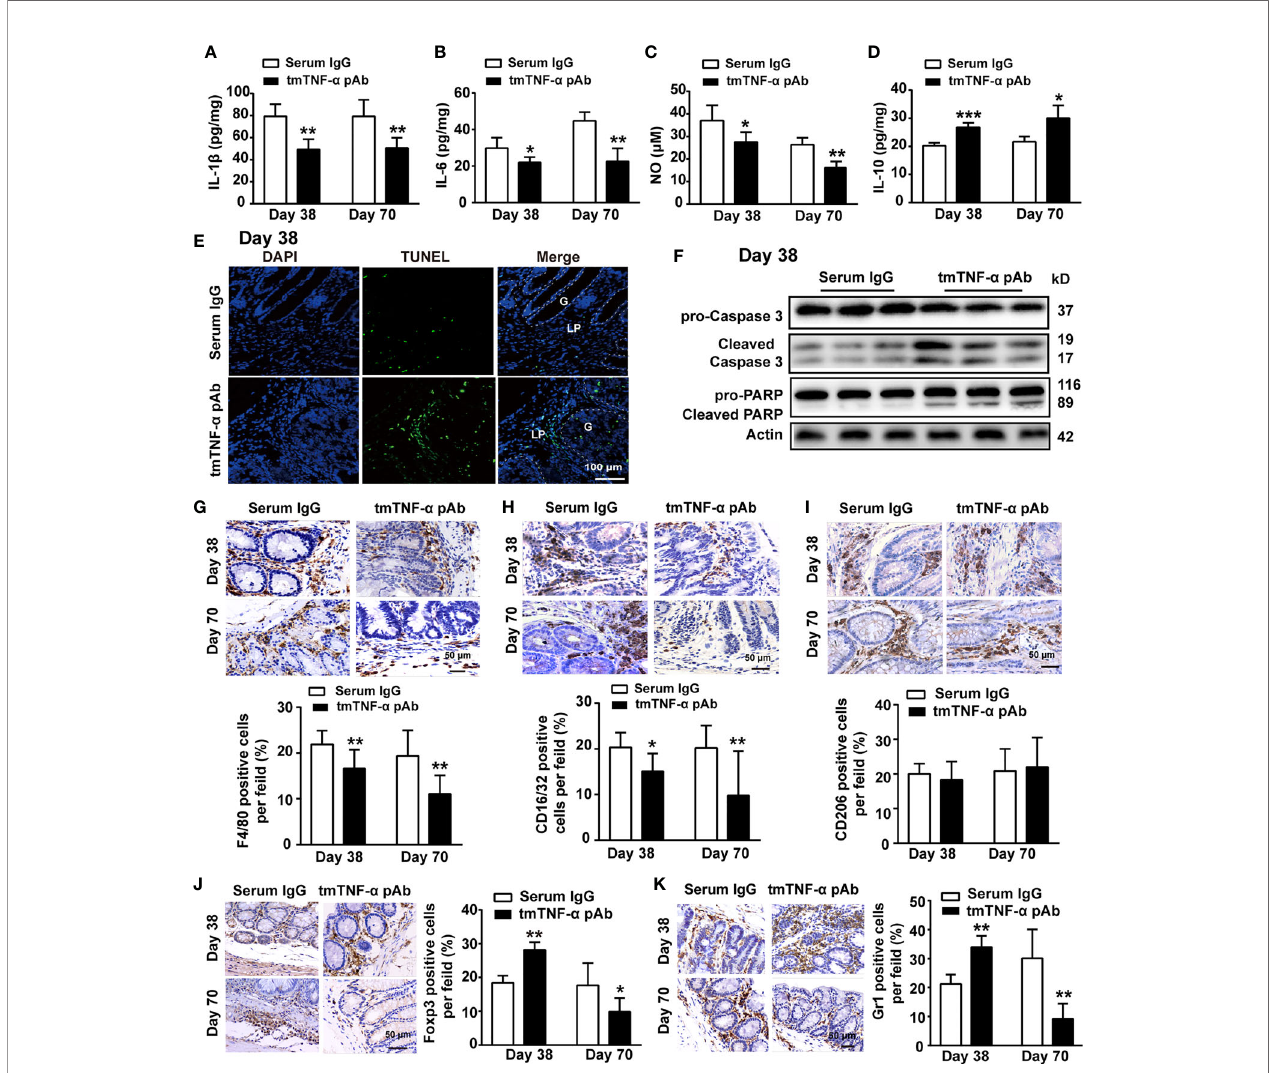
FIGURE 6 | tmTNF- a antibody treatment in the fi rst in fl ammation stage inhibits in fl ammation. tmTNF- a pAb was administered in the in fl ammation stage as described in Figure 5A (n = 5, each group). Concentrations of IL-1 b (A) , IL-6 (B), and IL-10 (D) in colonic tissue homogenates detected by ELISA. The levels of NO (C) in colonic tissue homogenates measured by Griess method. (E, F) Representative images of apoptosis in diseased colons detected by TUNEL (×200), and the western blot analysis for cleavage of caspase 3 and PARP on day 38. G: glands; LP: lamina propria. (G – K) Representative immunohistochemistry images of F4/80 + Macrophages, CD16/32 + type 1 or CD206 + type 2 macrophages, Foxp3 + Tregs and Gr1 + MDSCs in colonic tissues (×400) and their quantitative data. All quantitative data represent the mean ± SEM. *P < 0.05, **P < 0.01, ***P < 0.001 versus serum